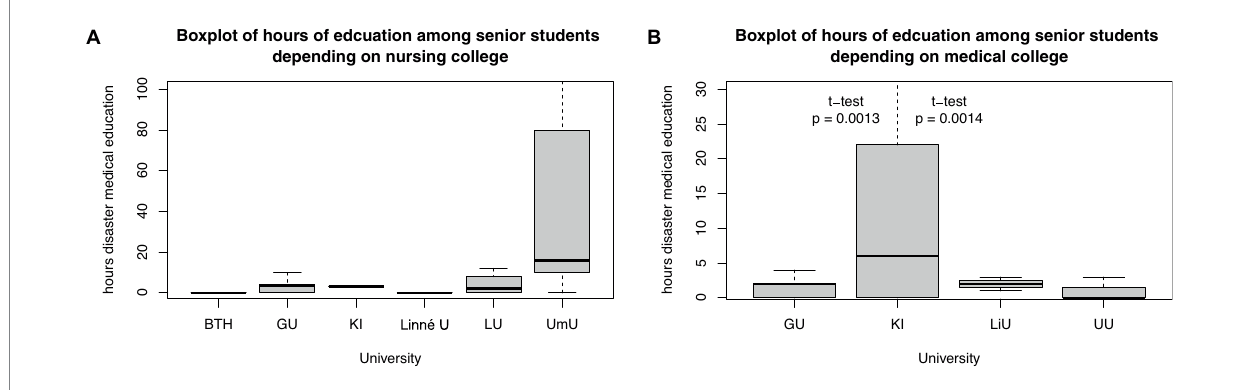
FIGURE 4 Boxplot of hours of education among senior (A) nursing and (B) medical students depending on their university.